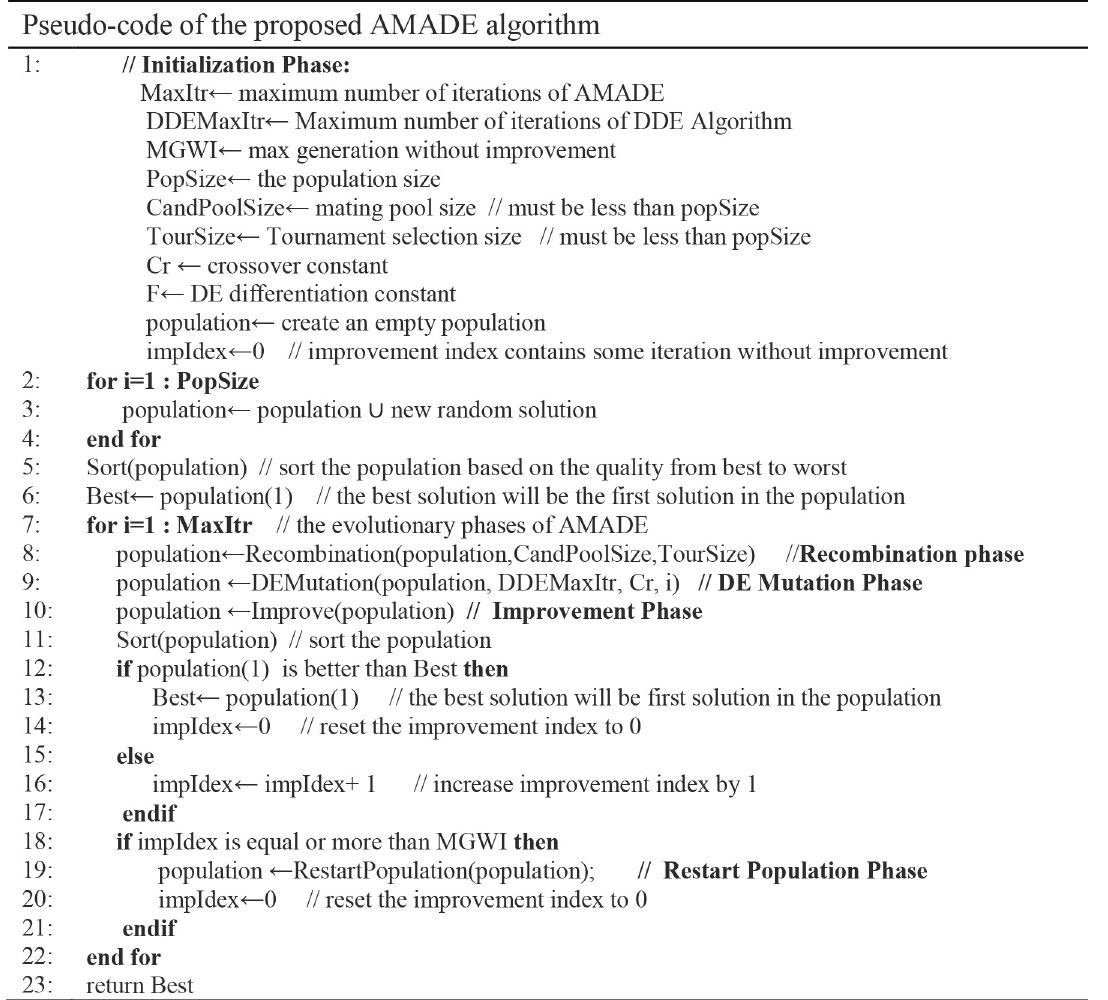
Fig 3. Pseudo-code of the proposed AMADE